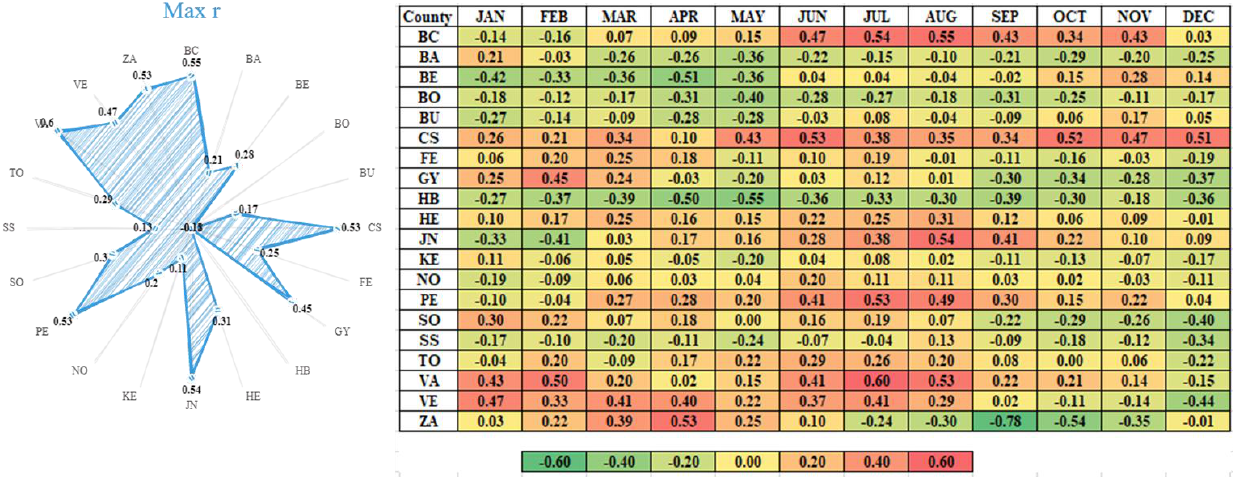
Figure 7. Correlation values between SSYR and SPI during the sunflower growing cycle (2000–2010) ( right table), and max correlation (Max. r) between the SSYR and SPI ( left figure).